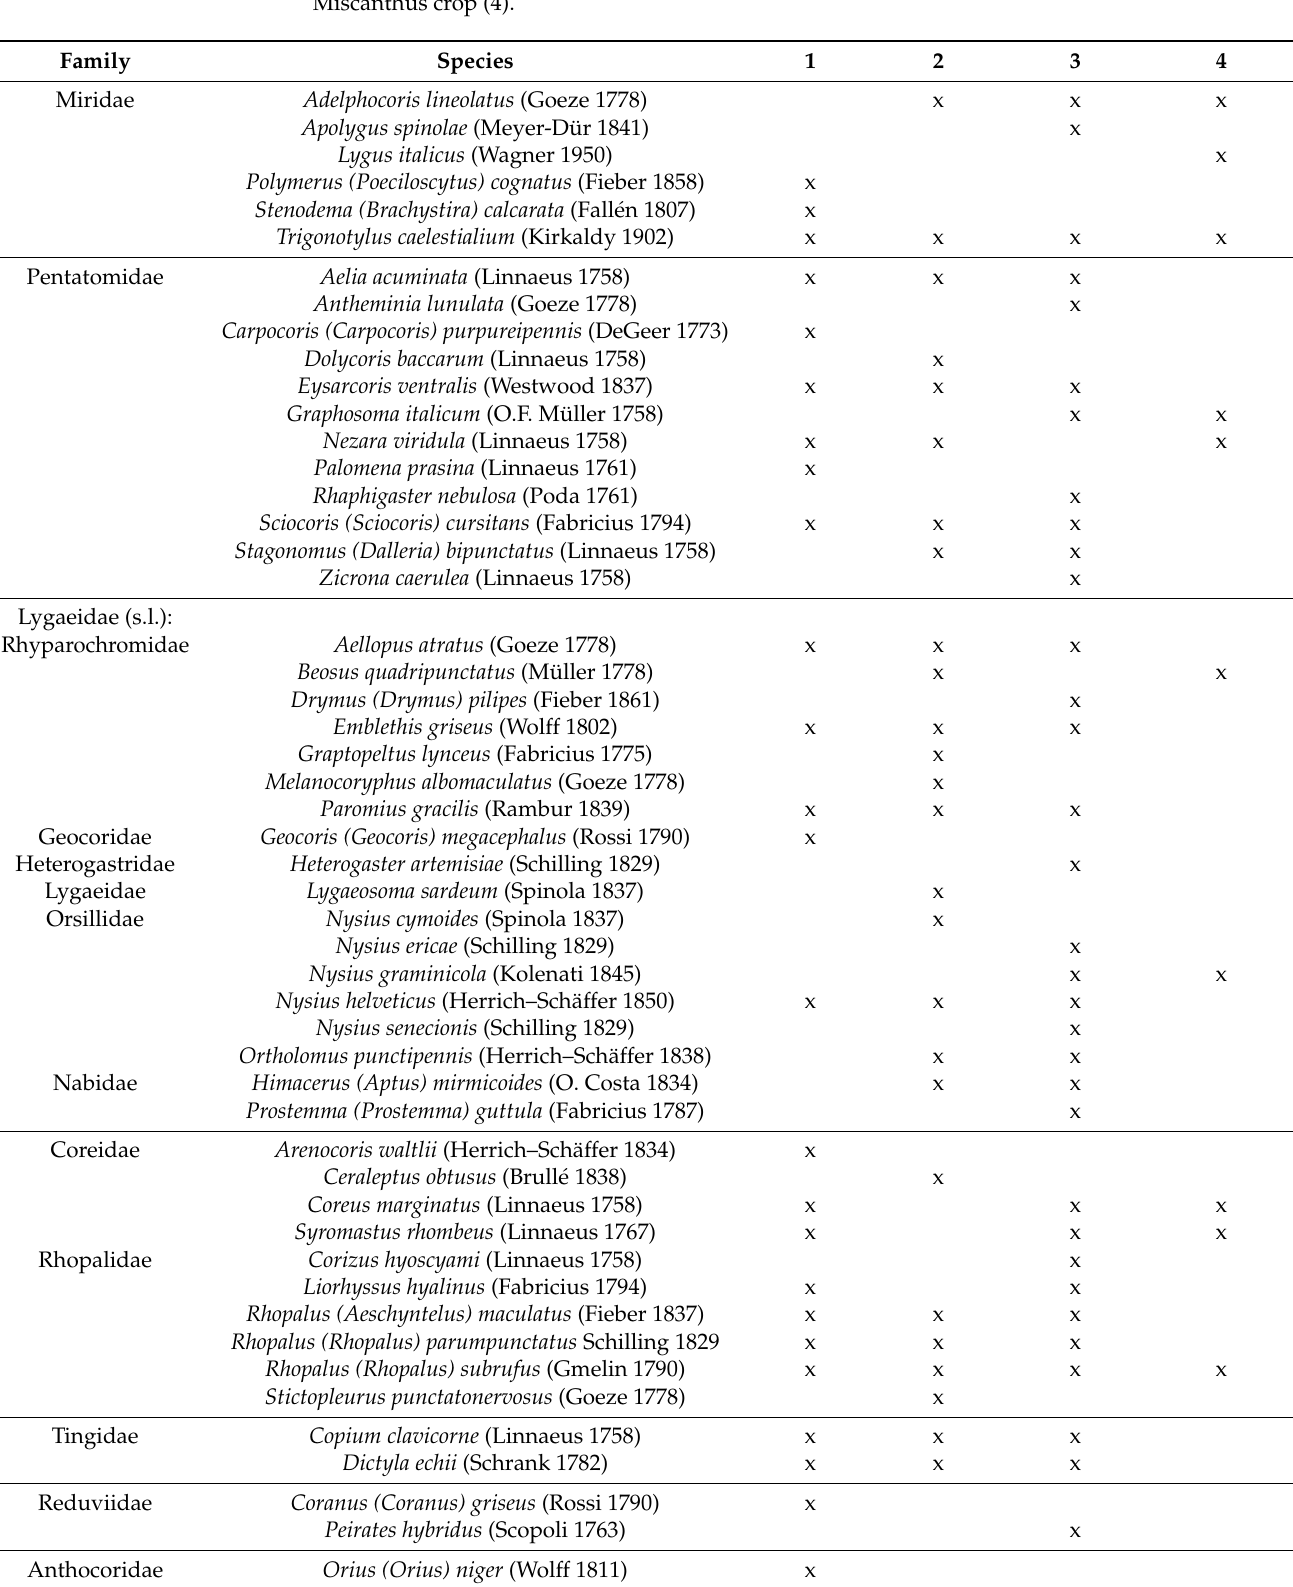
Table 1. Heteroptera species collected in Malpaga-Basella Nature Reserve (1, 2, 3) and in the giant Miscanthus crop